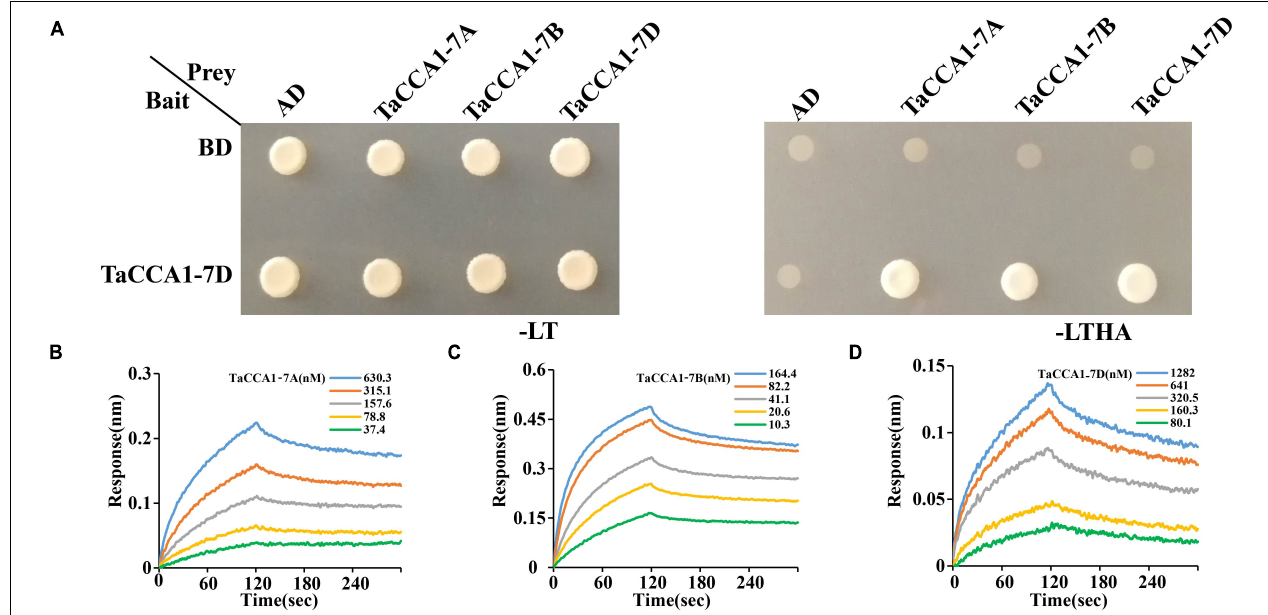
FIGURE 4 | TaCCA1s can form homodimers and heterodimers in vitro . (A) Interaction analysis between TaCCA1-7D and TaCCA1-7A, as well as TaCCA1-7B and TaCCA1-7D in yeast cells. Yeast cells growing on selective media without Leu, Trp, His, and Ade (-LTHA) represent positive interactions. (B–D) Biolayer interferometry confirms the interaction between TaCCA1-7D with TaCCA1-7A, TaCCA1-7B, and